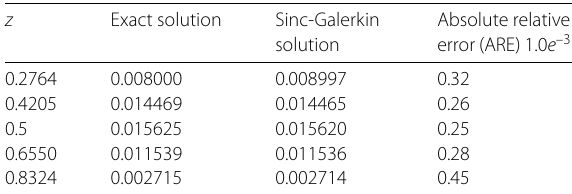
Table 12 The maximum absolute errors of Problem 3 from [9]